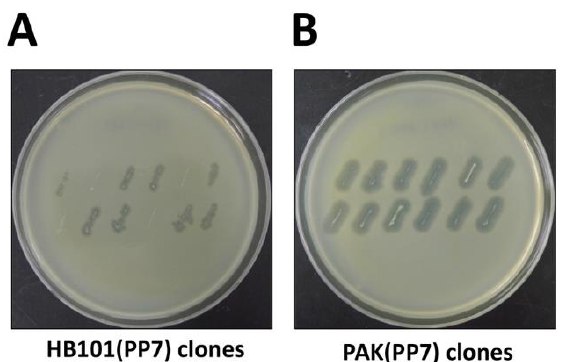
Figure 2. Streak assay for phage production. Bacterial colonies of the surrogate hosts bacteria, E. coli HB101 ( A . HB101(PP7)) or P. aeruginosa PAK ( B . PAK(PP7)) clones were streaked onto the plates overlaid with the lawns of PP7-susceptible P. aeruginosa PAO1. The plates were incubated at 37 °C for 18 h.